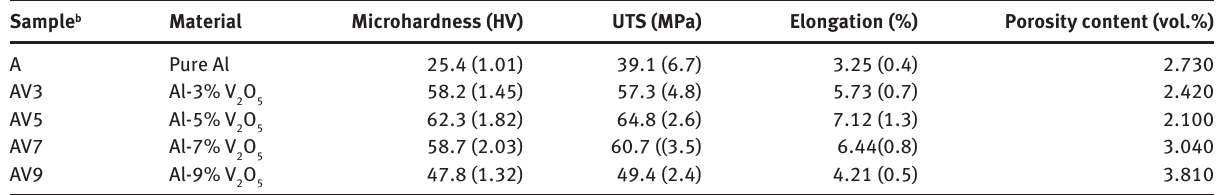
Figure 6: (A) micrograph of pure aluminum; (B) shows the micrograph Al-3% V high magnification; (E) Al-7% V Table 2: Mechanical properties and porosity content for different reinforcements a . Sample